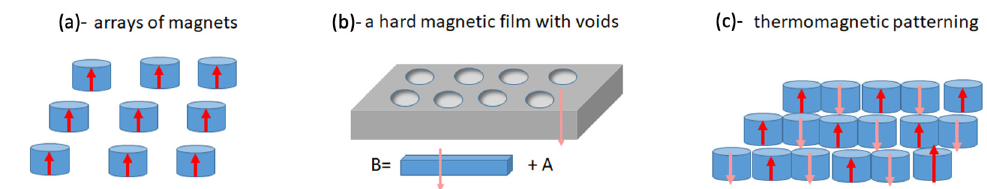
Figure 11. Schematics of micromagnetic arrays. ( a ) Basic system of uniformly magnetised cylinders (along the height or along the diameter); ( b ) uniformly magnetised magnetic film with voids that magnetically is equivalent to the combination of a uniform film and a system of cylinders magnetised oppositely to the film; ( c ) an array produced by thermomagnetic patterning corresponds to an array of closely spaced cylinders with mutually opposite magnetisation.